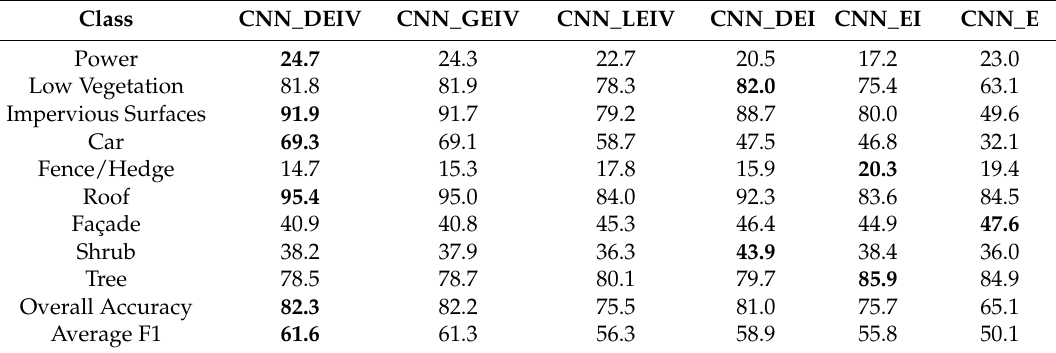
Table 4. The recall value, the overall accuracy of each class and the average F1 value for different feature selections in (%). Bold numbers show the highest value within the different features.